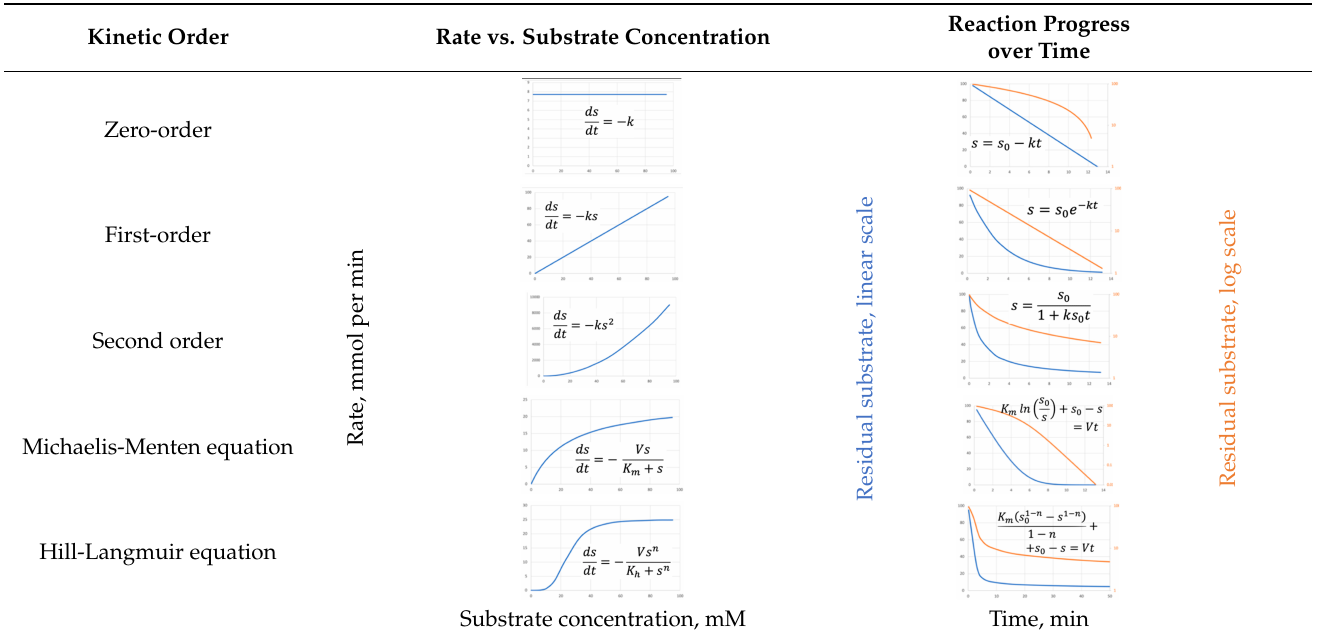
Table A1. Basic equations used in chemical and enzyme